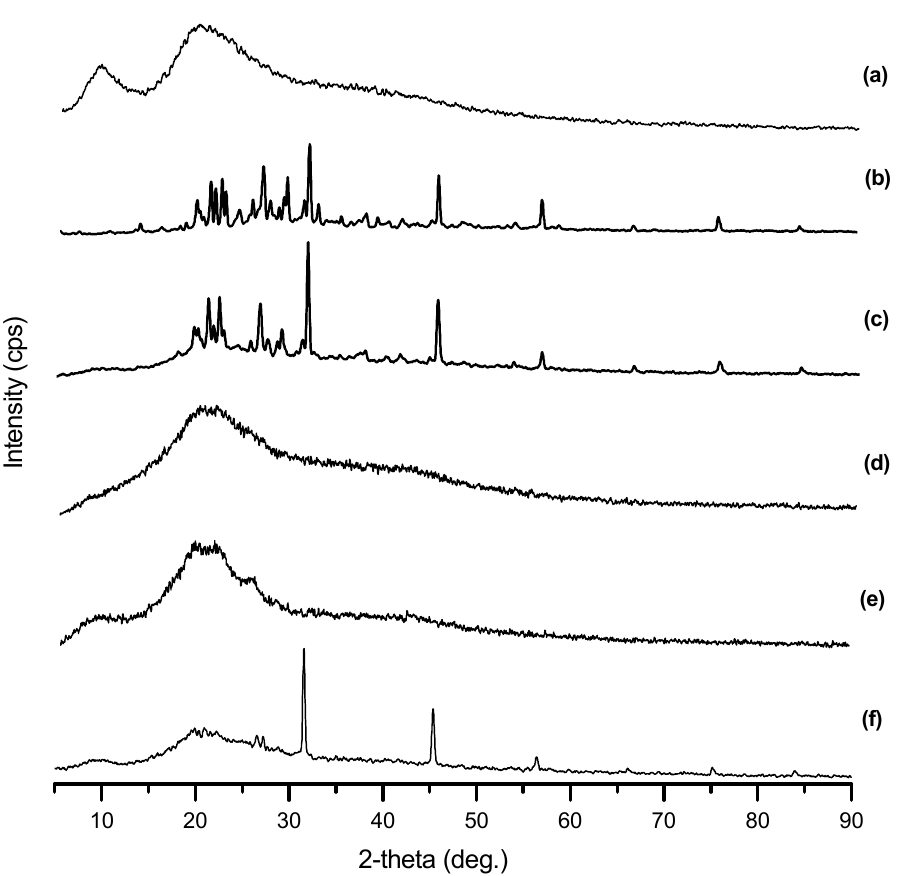
Figure 4. X-ray diffractograms of ( a ) zein, ( b ) AZP, ( c ) DHAB, ( d ) gelatin, ( e ) IgG and ( f ) IgG loaded AZP nanospheres.